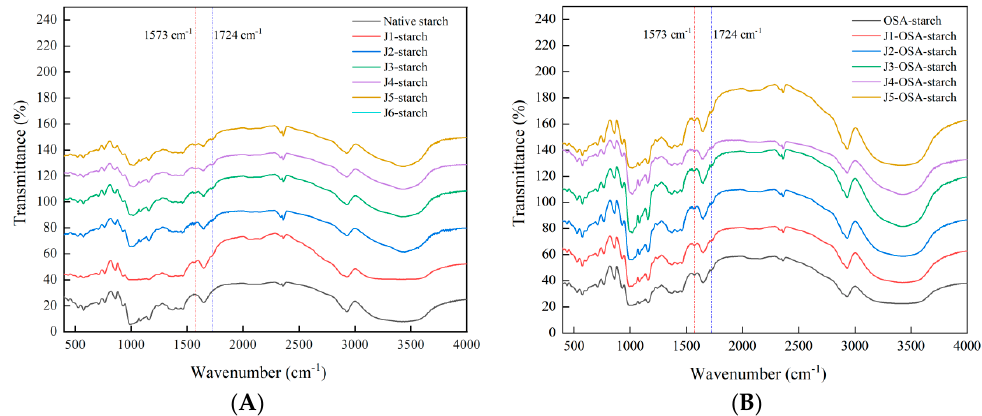
Figure 3. FTIR spectra of J-starch and J-OSA-starch: ( A ), FTIR patterns of J-starch; ( B ), FTIR patterns of J-OSA-starch. of J-OSA-starch.